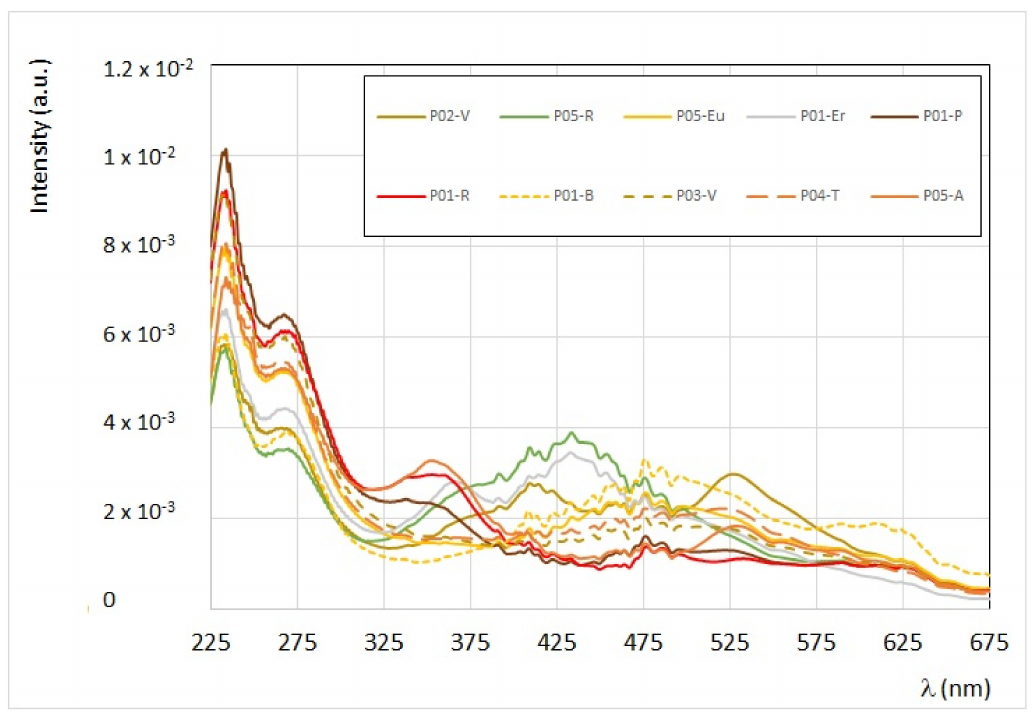
Figure 1. Superposition of synchronous front-face fluorescence (FFF) spectra ( ∆ λ = 60 nm) of the ten bee pollen samples recorded in bulk. The intensity was first corrected by the di ff usion contribution [30,32] and then normalized. Sharp signals between 400 and 500 nm are due to the xenon